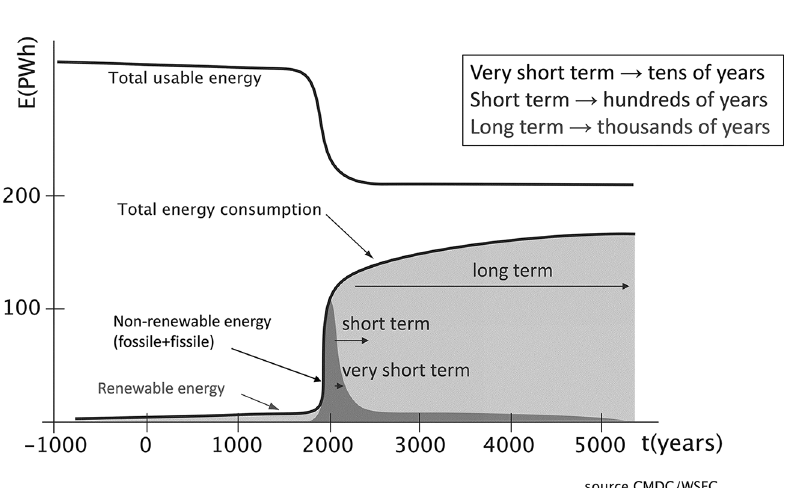
Fig. 1. – Total energy available and energy consumption in a civilisation time scale. The dark surface indicate the non-renewable energy consumed in the last couple of